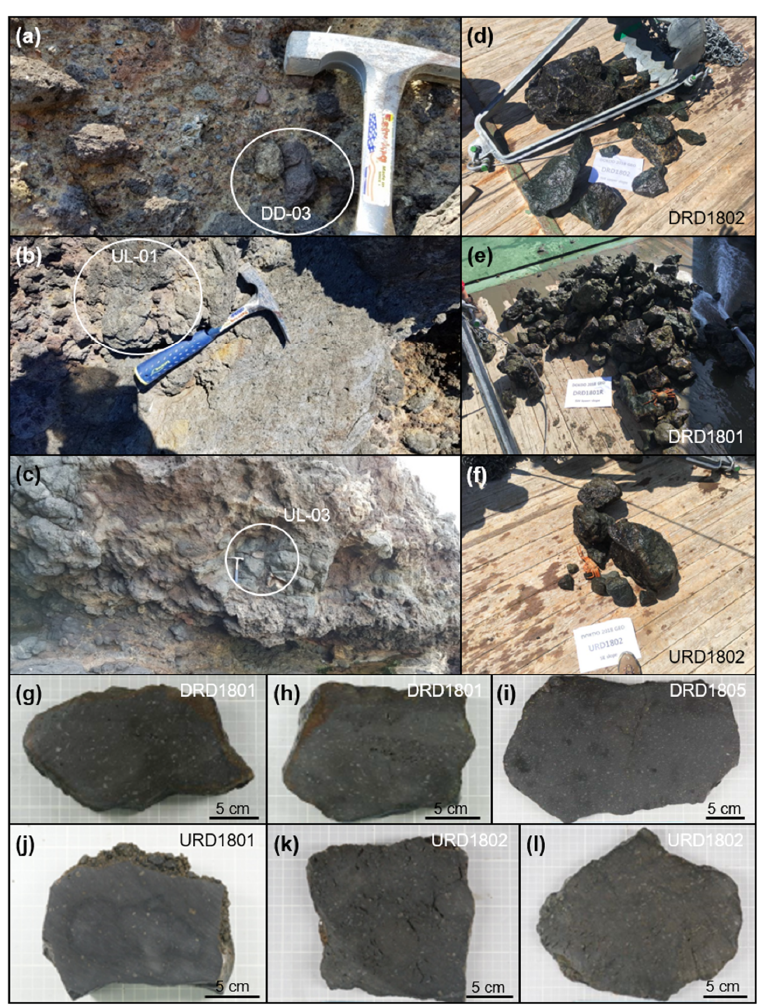
Figure 2. Photographs of terrestrial samples from ( a ) Dokdo and ( b , c ) Ulleung islands and submarine samples from ( d , e , g – i ) Dokdo and ( f , j – l ) Ulleung islands. ( a , d – l ) are trachytic rocks, whereas ( b , c ) are basaltic agglomerate samples. ( d – f ) the dredged rock samples of Onnuri R/V. The sampling location is shown in Figure 1.